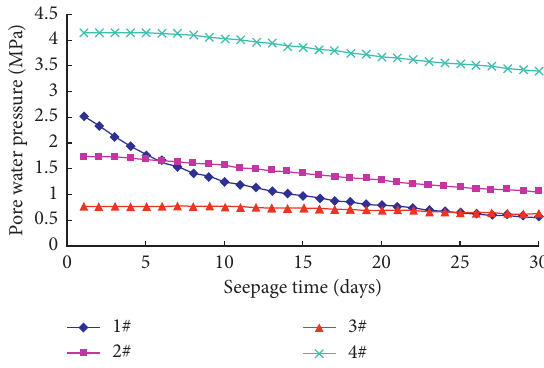
Figure 13: Pore water pressure-seepage time curve at each measuring